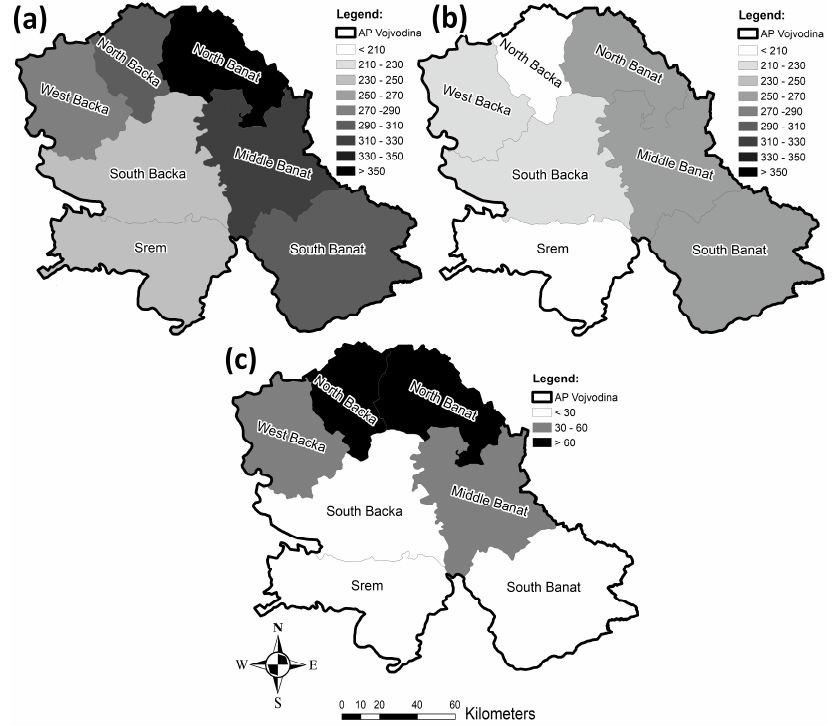
Figure 14. Incidence rates per 100,000 population for cardiovascular diseases in the researched area from 2010 to 2020: ( a ) acute coronary syndrome incidence rates, ( b ) myocardial infarction incidence rates, and ( c ) unstable angina pectoris incidence rates.